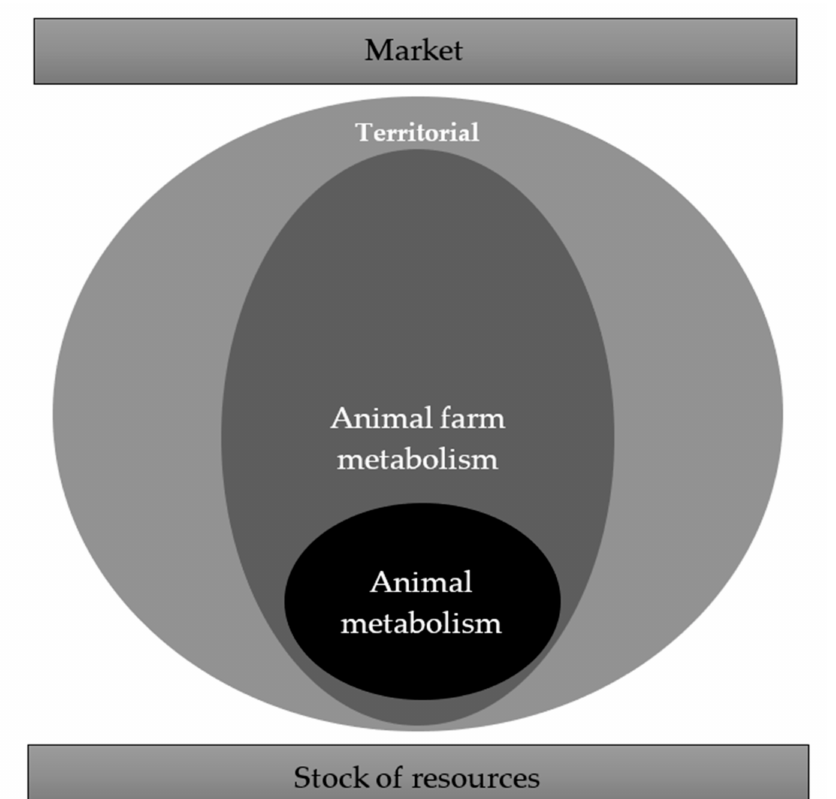
Figure 1. Functional spaces and circular economy in animal